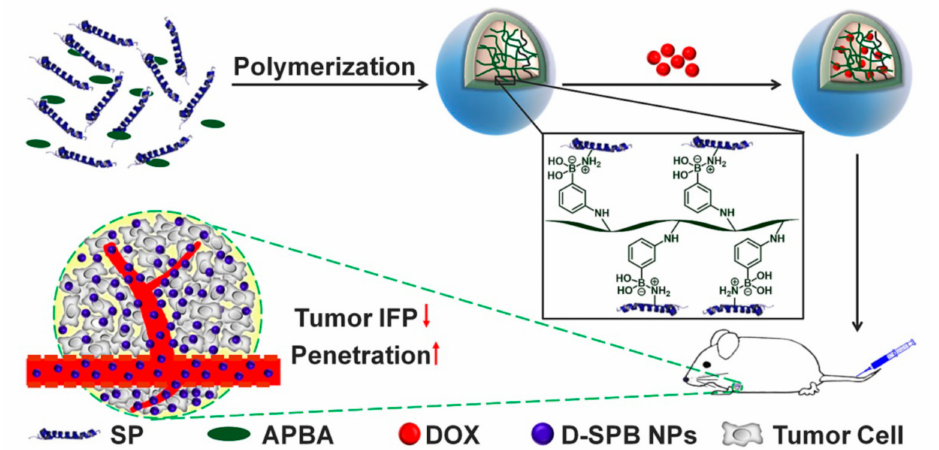
Figure 19. Representation of preparing and delivering soy protein nanoparticles into tumor cells. Soyprotein (SP), acrylamidophenylboronic acid (APBA), Doxorubicin (DOX), phenylboronic acid- decorated soy protein nanoparticles (D-SPB) Reprinted with permission from ref. [116]. Copyright 2019 Ivyspring International